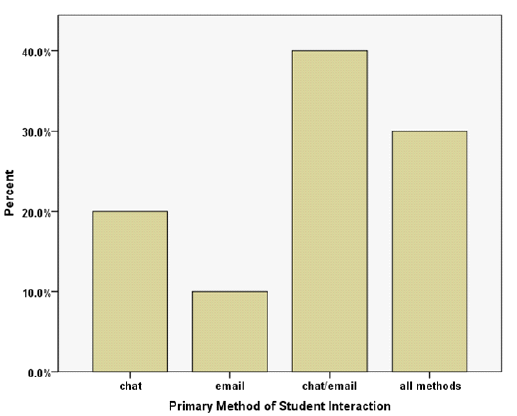
Figure 3 . Distribution of ten online courses based on the primary method of student interaction.